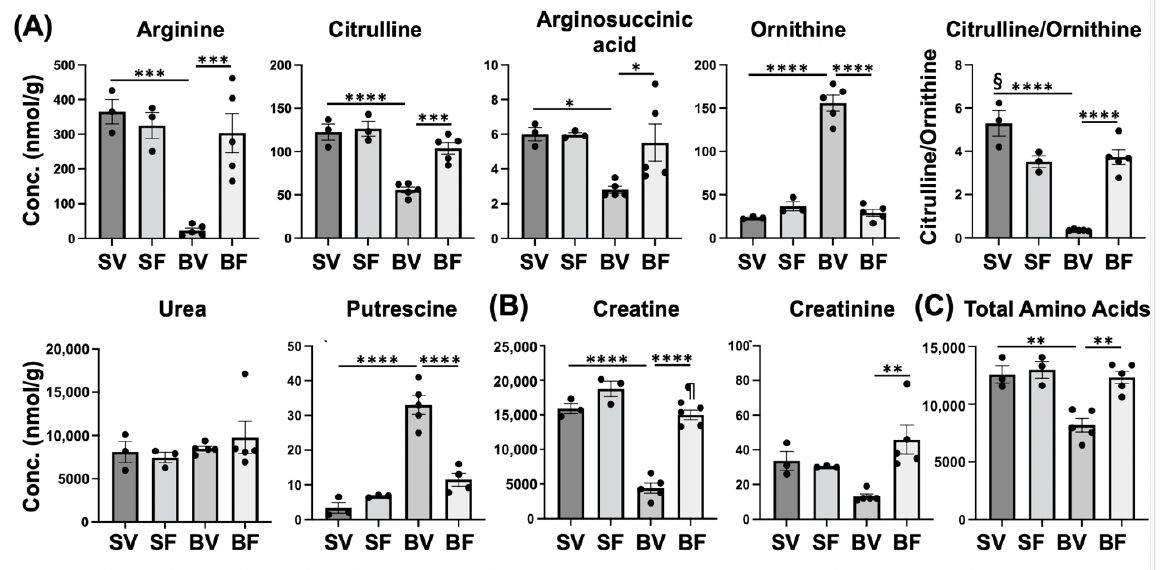
Figure 8. Effects of burn injury and FTI-277 on metabolites related to the urea/ornithine cycle (A), creatine metabolism (B), and total amino acids (C). SV: Sham-Vehicle; SF: Sham-FTI; BV: Burn-Ve- hicle; BF: Burn-FTI, * p < 0.05, ** p < 0.01, *** p < 0.001, **** p < 0.0001, § p < 0.05 vs. Sham-FTI and Burn-FTI, ¶ p < 0.05 vs. Sham-FTI .